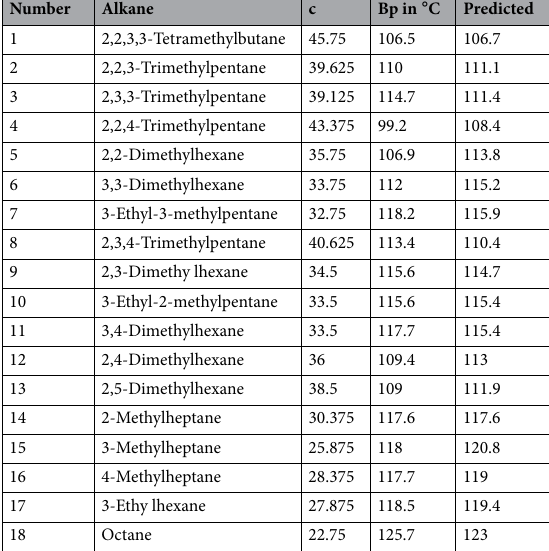
Table 9. All alkanes of order 8: Predictive ability of model (8).